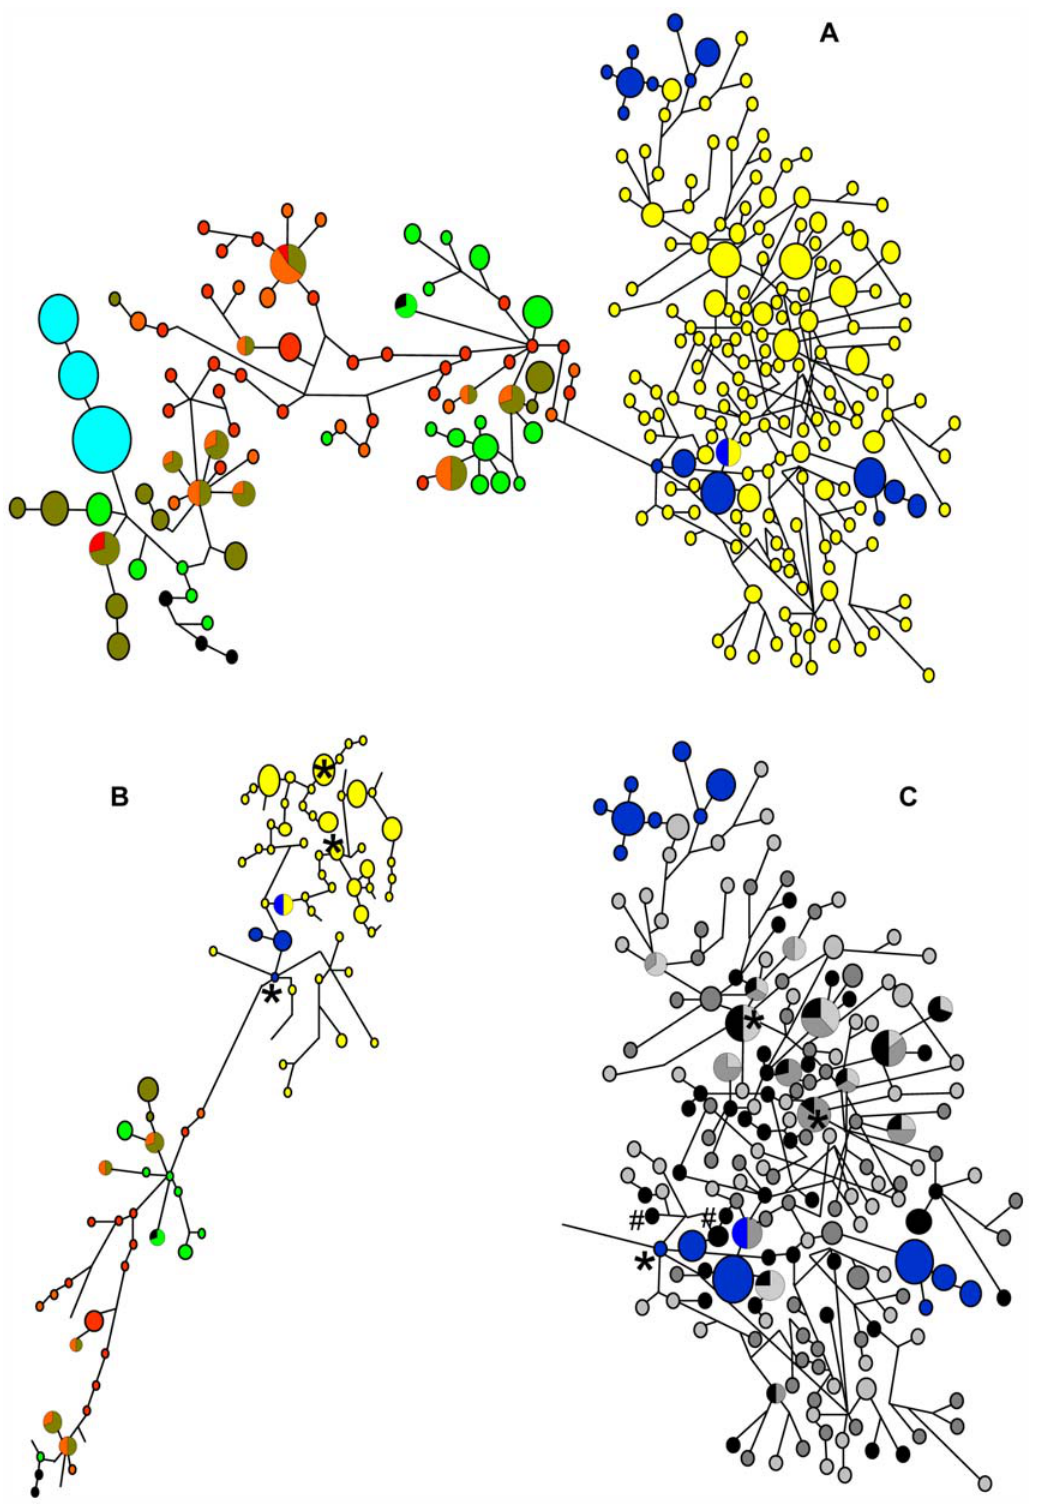
Figure 2. Networks of phylogenetic relationships among ancient and extant mitochondrial DNA haplotypes. (A) Median-joining network where the size of the circle indicates relative frequency of the haplotype. Yellow – Victoria Land Coast (VLC); dark blue – Macquarie Island (MQ); brown – Falklands; orange – Elephant Island; green – Marion Island; light blue – Peninsula Valde´s; red – South Georgia; black – Heard Island. South Georgia and Heard Island relationships are based on 240 bp of mtDNA (see Materials and Methods). Networks were post-processed to reduce complexity using the Maximum Parsimony option in Network 4.5 [13]. (B) Network showing torso only, illustrating major connections among basal haplotypes. Image has been rotated to fit the page. Samples coloured as in part ‘A’. Likely VLC founder haplotypes, based on rho ( r ) estimates, indicated by ‘*’. (C) MQ and VLC clade only, illustrating relationship between MQ haplotypes and the age of the VLC samples. Blue: MQ; light gray: